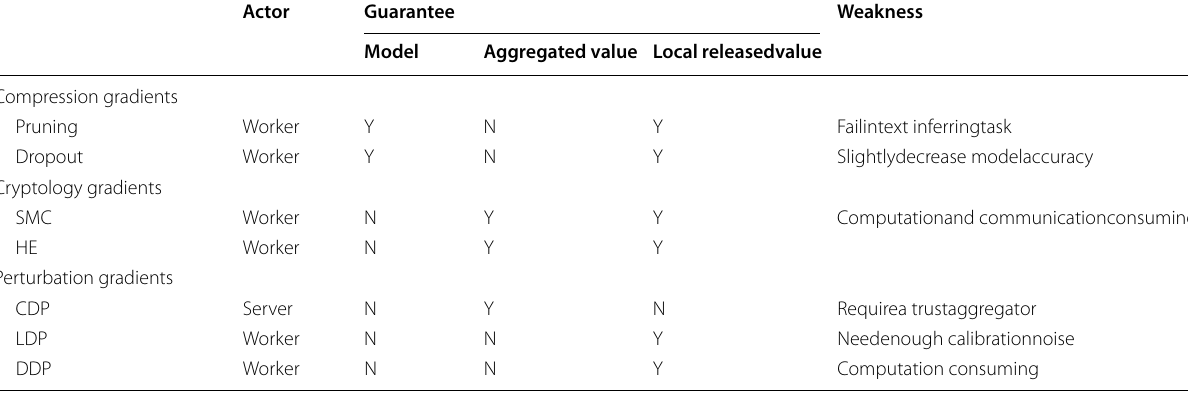
Table 3 Defense methods against privacy inference attacks in the training